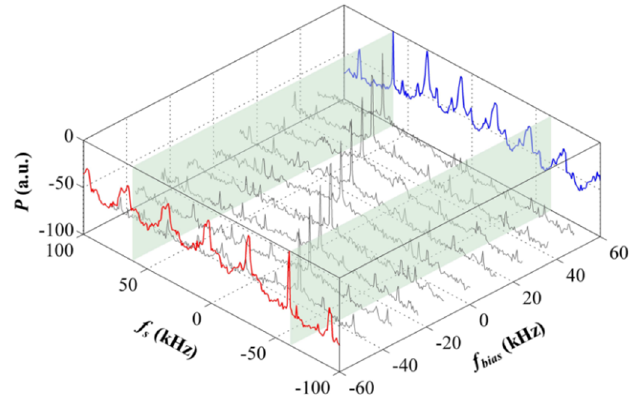
Figure 7. Spectra of beat signals locked with different frequency bias values.